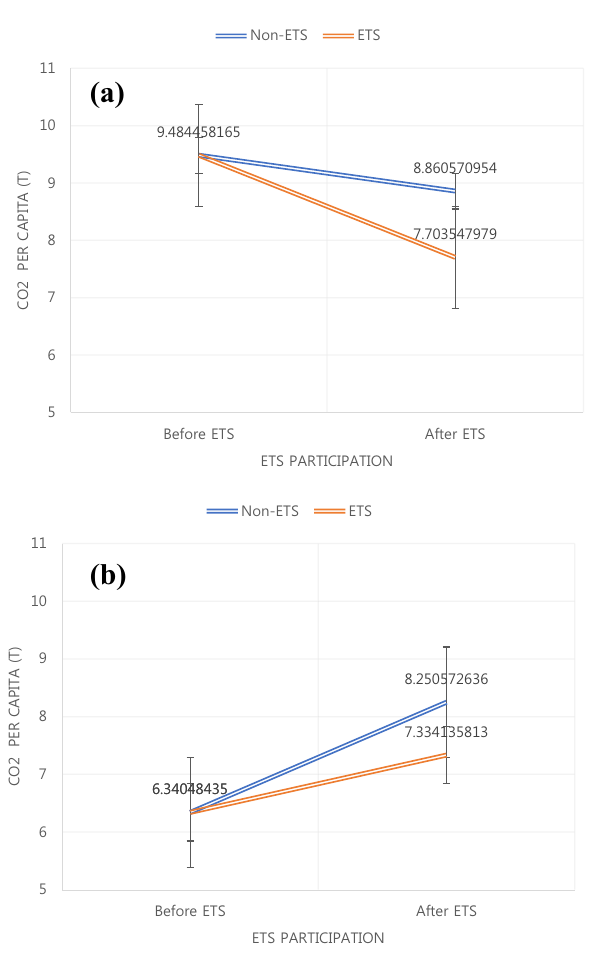
Figure 4. Difference in carbon emission per capita between the countries that have and have not adopted the emission trading scheme (ETS) after and before crossing the turning point. ( a ) Carbon emission per capita in countries after crossing the turning point. ( b ) Carbon emission per capita in countries before crossing the turning